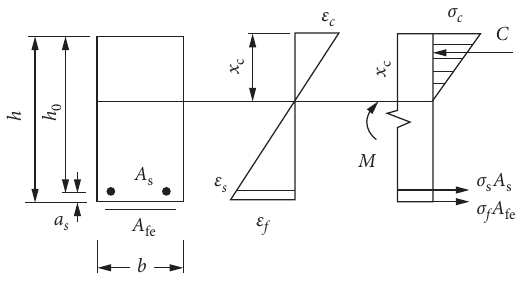
Figure 13: Cross-sectional diagram of